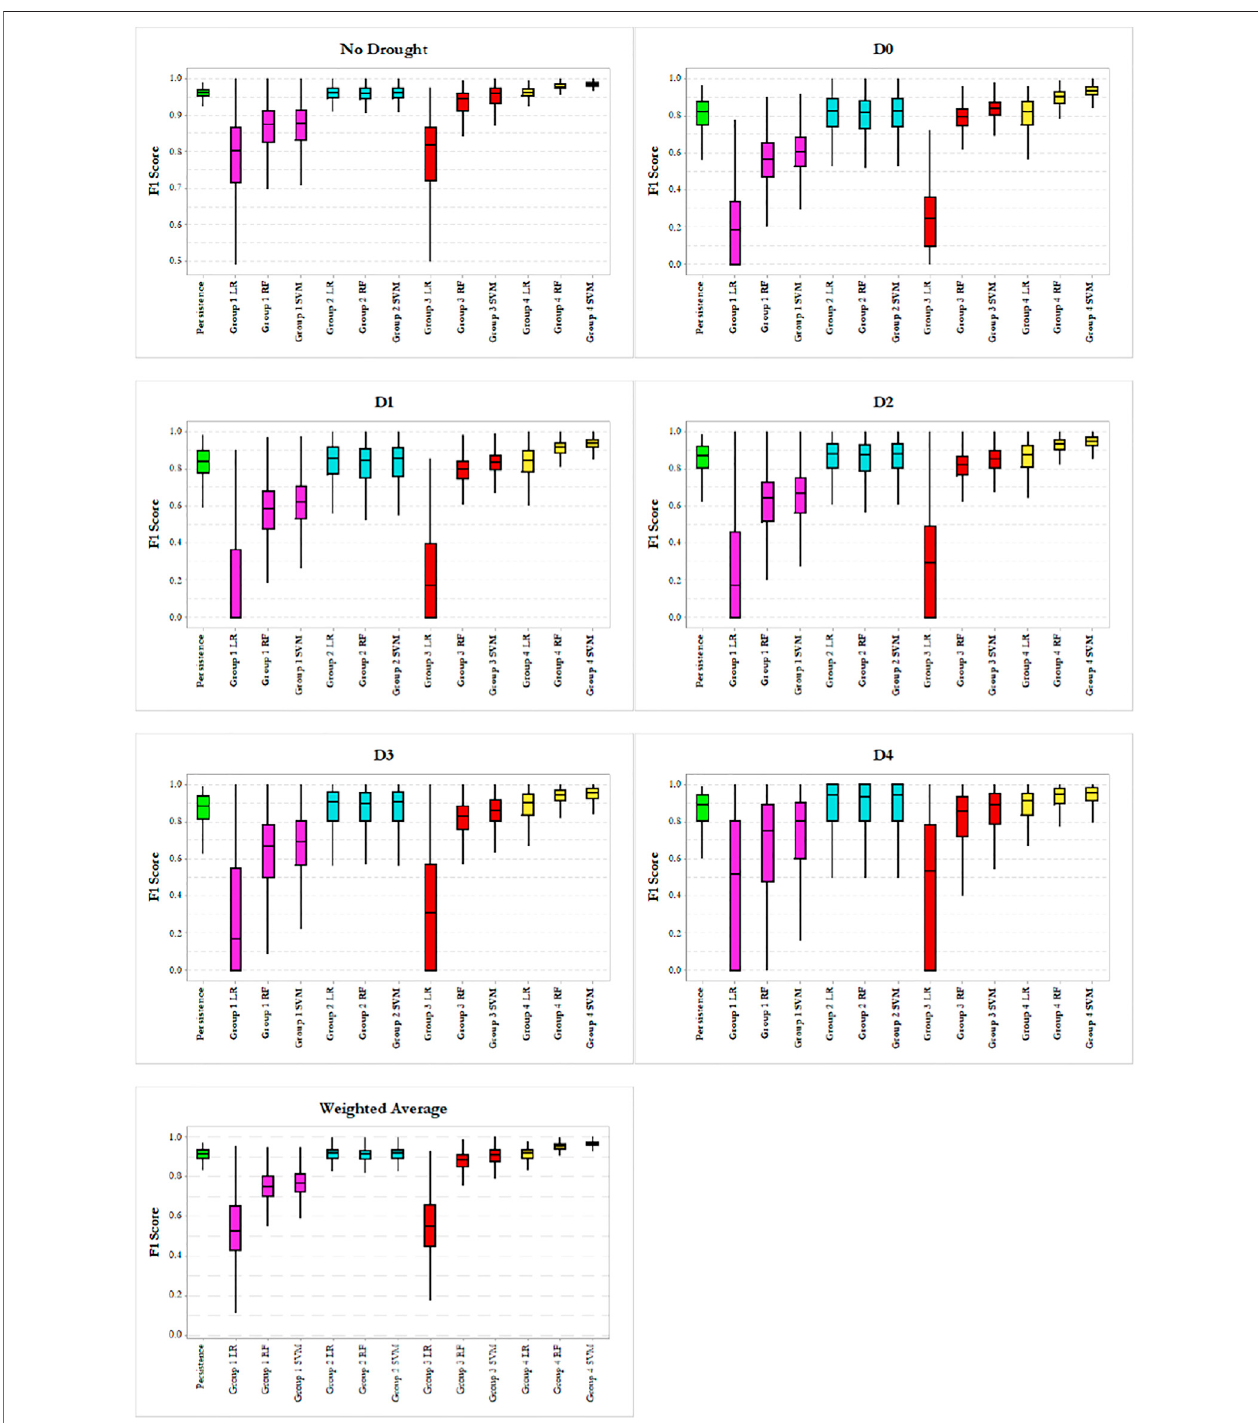
FIGURE 5 | Side by side comparison of the model ’ s overal and for each drought category performances.